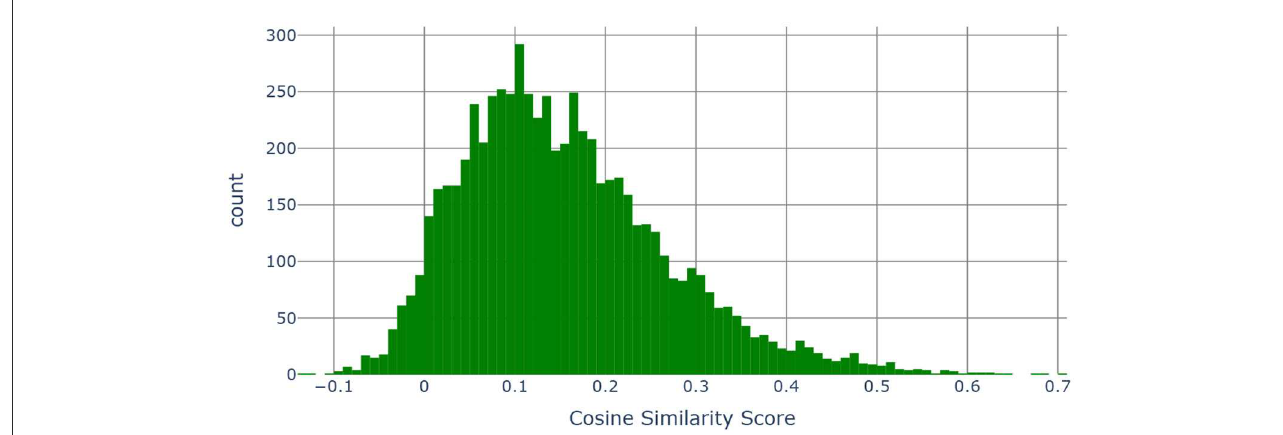
FIGURE9 Histogram of the cosine similarities between the embedding vectors of “category, subcategory 1, subcategory 2, subcategory 3 and the definition” and “PhenX categories”.